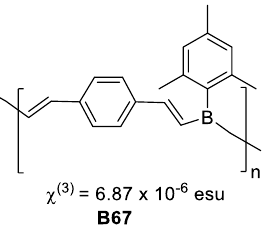
Figure 27. Polymer based on diethynylbenzene third-order nonlinear optical susceptibility value.